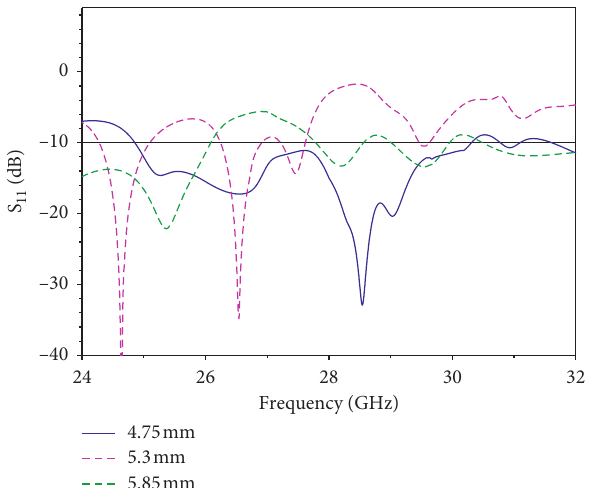
Figure 7: S 11 of corporate-fed microstrip array antenna with feed lengths 4.75 mm, 5.3 mm, and 5.85mm.